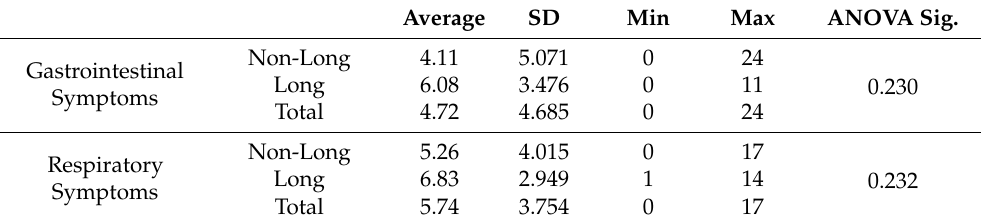
Table 5. Average score of symptoms according to the length of the